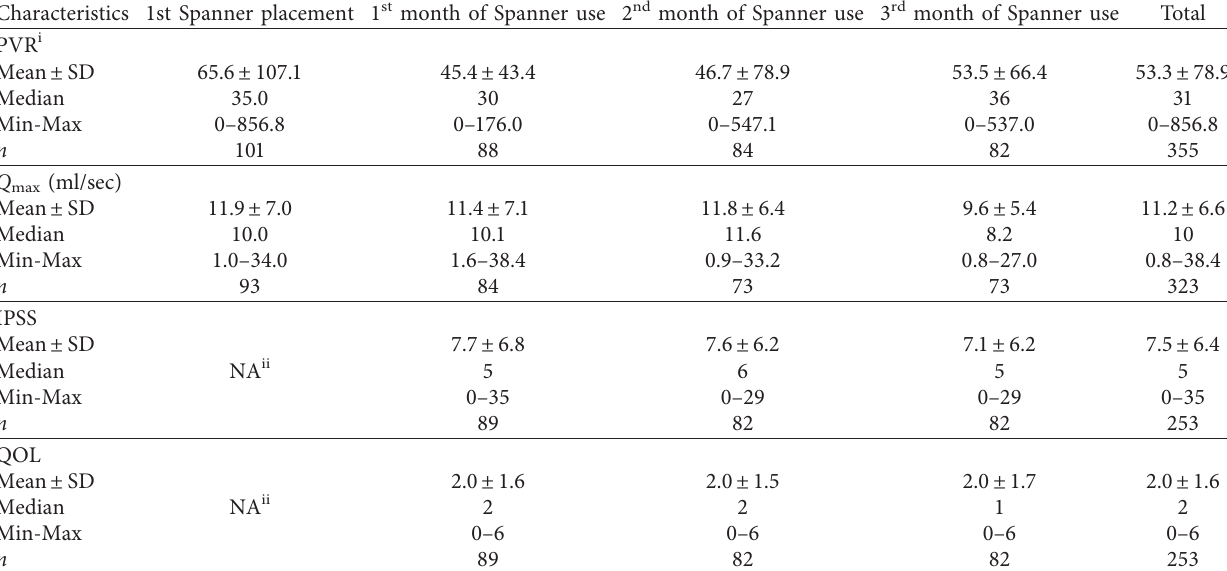
Table 4: PVR, Q max , IPSS, and QOL measured during Spanner